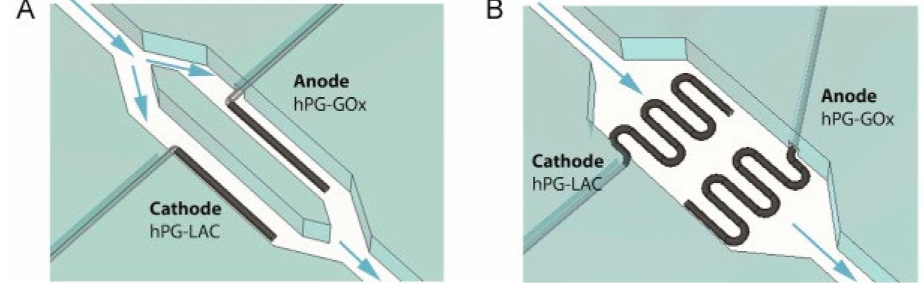
Figure 4. The two 3D-printing studied microfluidic enzymatic biofuel cells (MEFCs). ( A ) configuration with two parallel flow channels, ( B ) configuration with one single flow channel [42].